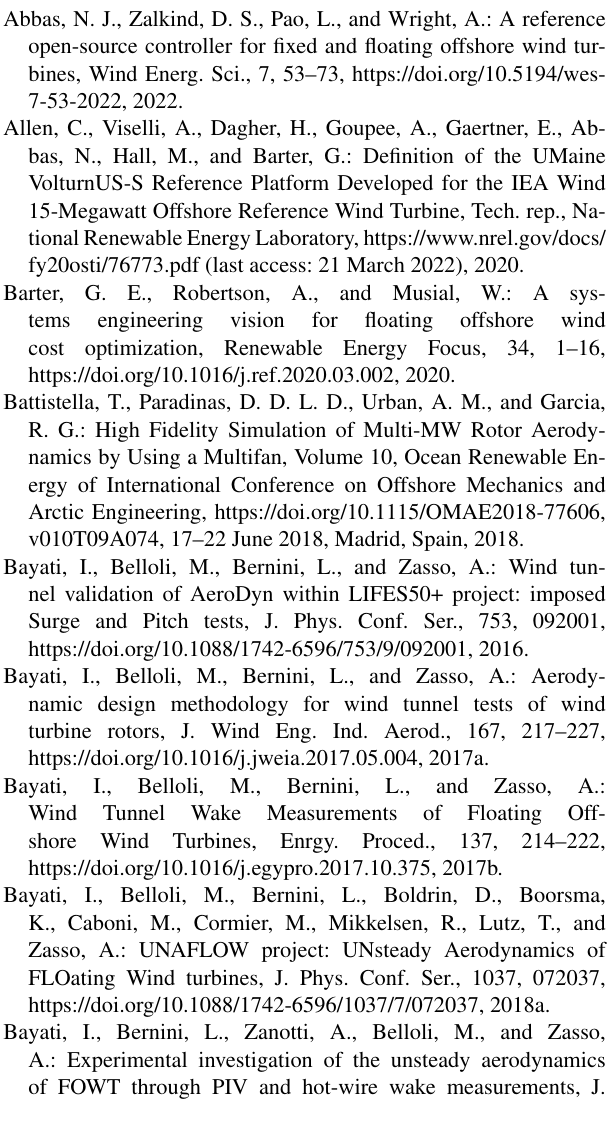
Figure B1. Sketch of the wind tunnel with the main dimensions of the atmospheric boundary layer test section where the experiments were carried out and position of the wake measurement